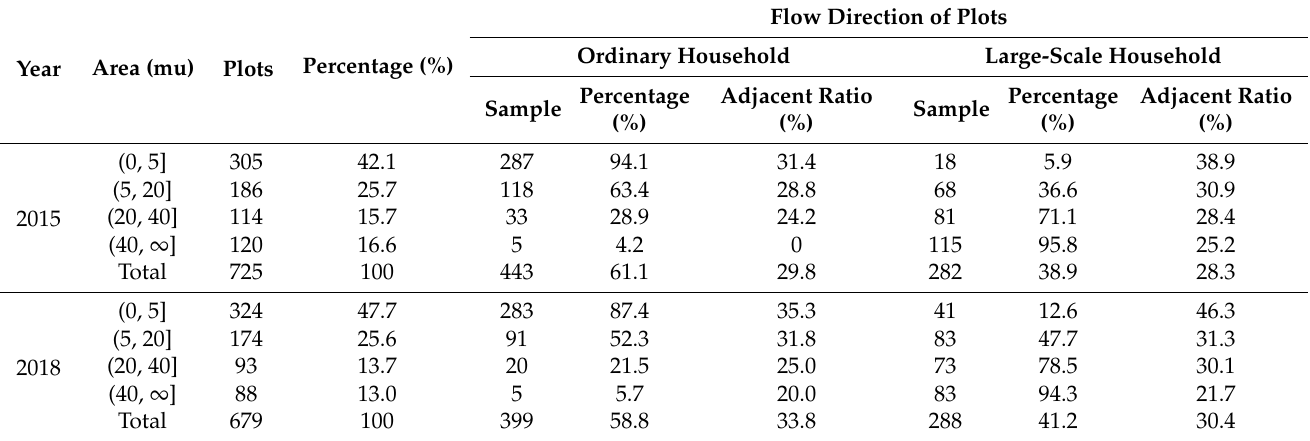
Table 3. Statistics of the flow direction of plots with different spatial characteristics in the survey.